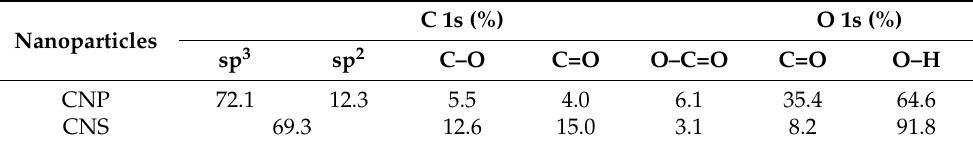
Table 2. Concentration of chemical bonds on the surface of CNS and CNP from XPS.